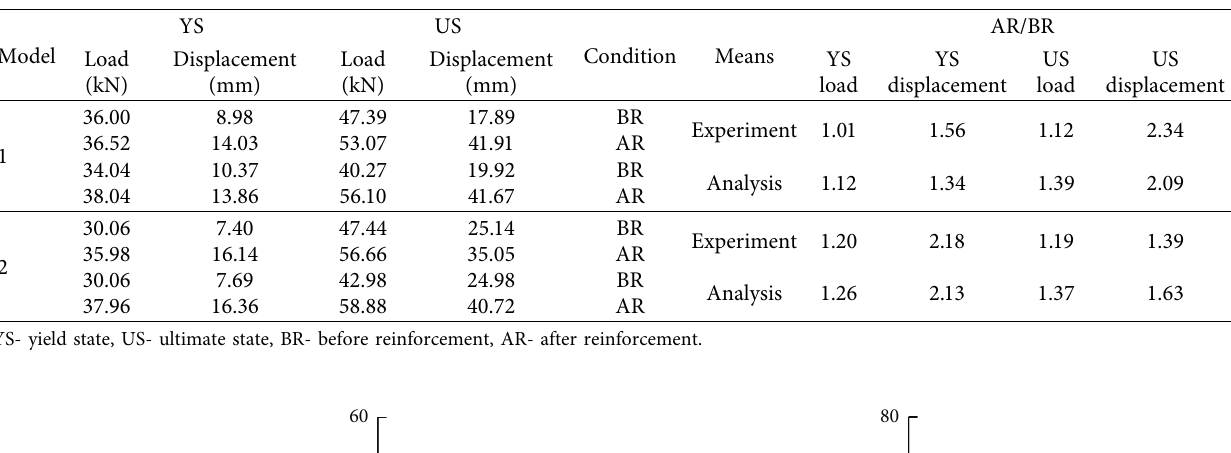
Table 4: Result of the experiment and analysis.